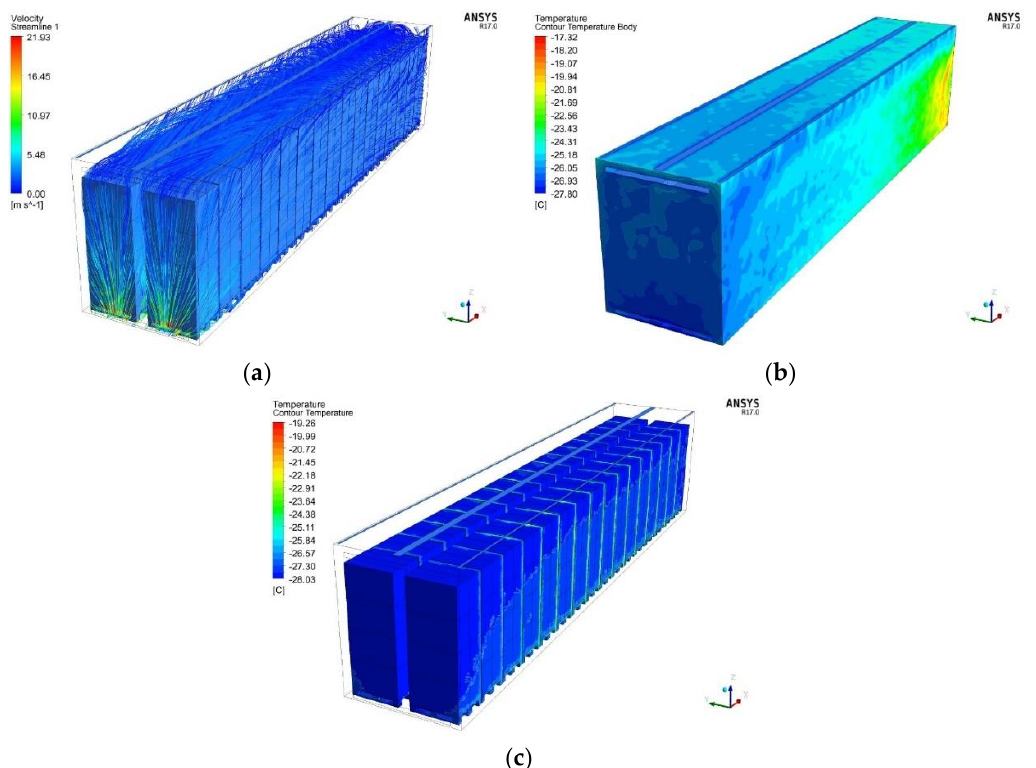
Figure 5. The stationary model of turbulent flow, method: RSM ( a ) streamline: velocity magnitude (m/s), ( b ) external temperature (°C) distribution, ( c ) internal temperature (°C) distribution.